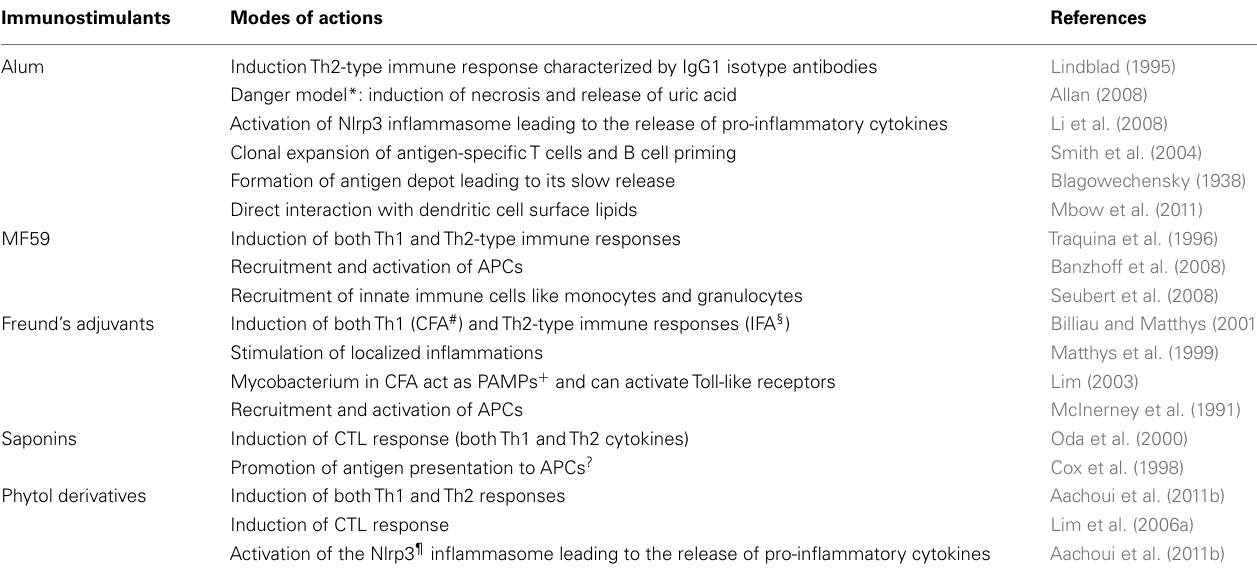
Table 2 | Comparison of the modes of action of phytol derivatives with other common adjuvants.